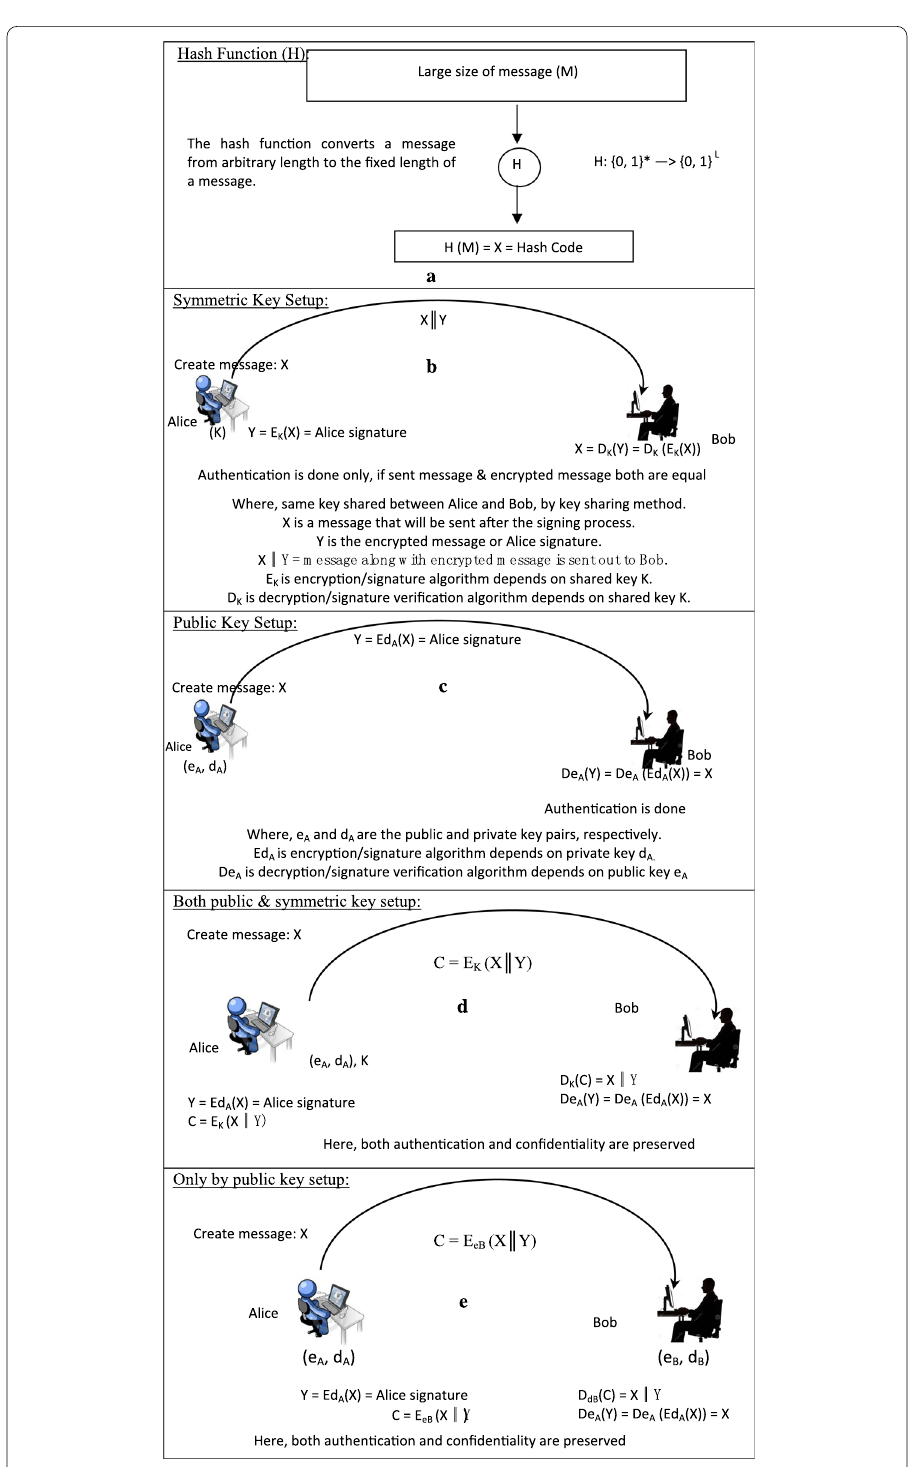
Fig. 6 a Hash function and Digital Signature: b Symmetric Key Set-up, c Public Key Set-up, d both Public and Symmetric Key Set-up, e Only by Public Key